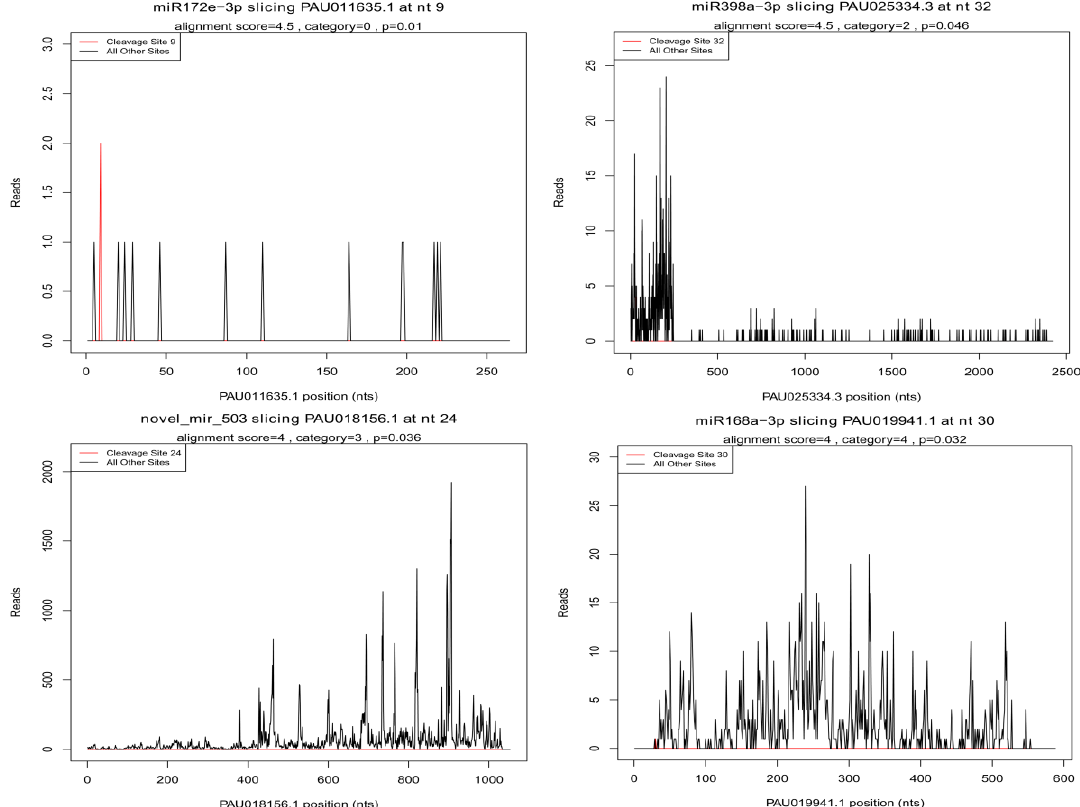
Figure 5. Target plots (t-plots) of miRNA targets in different categories confirmed by degradome sequencing.